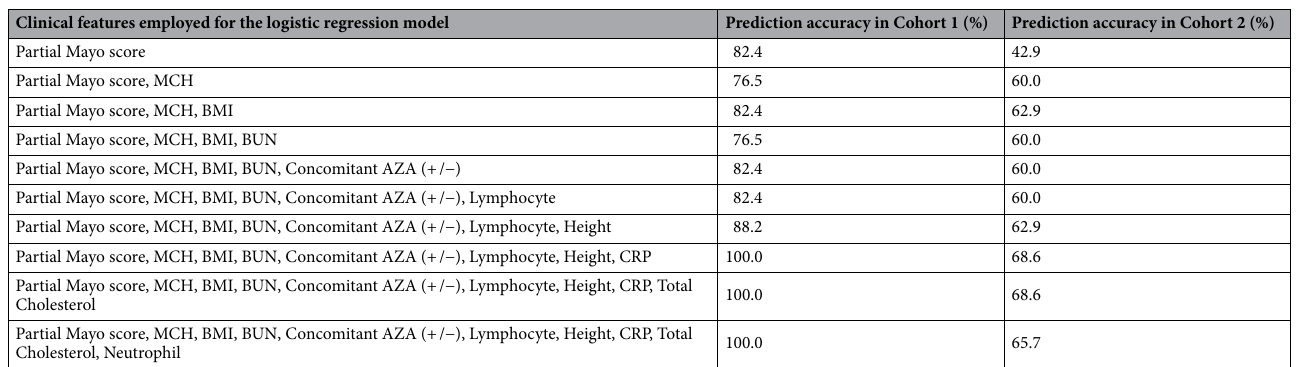
Table 4. Predictive accuracy of logistic regression models for steroid-free clinical remission at week 22 comprising the top 10 contributing clinical features. MCH mean corpuscular hemoglobin, BMI body